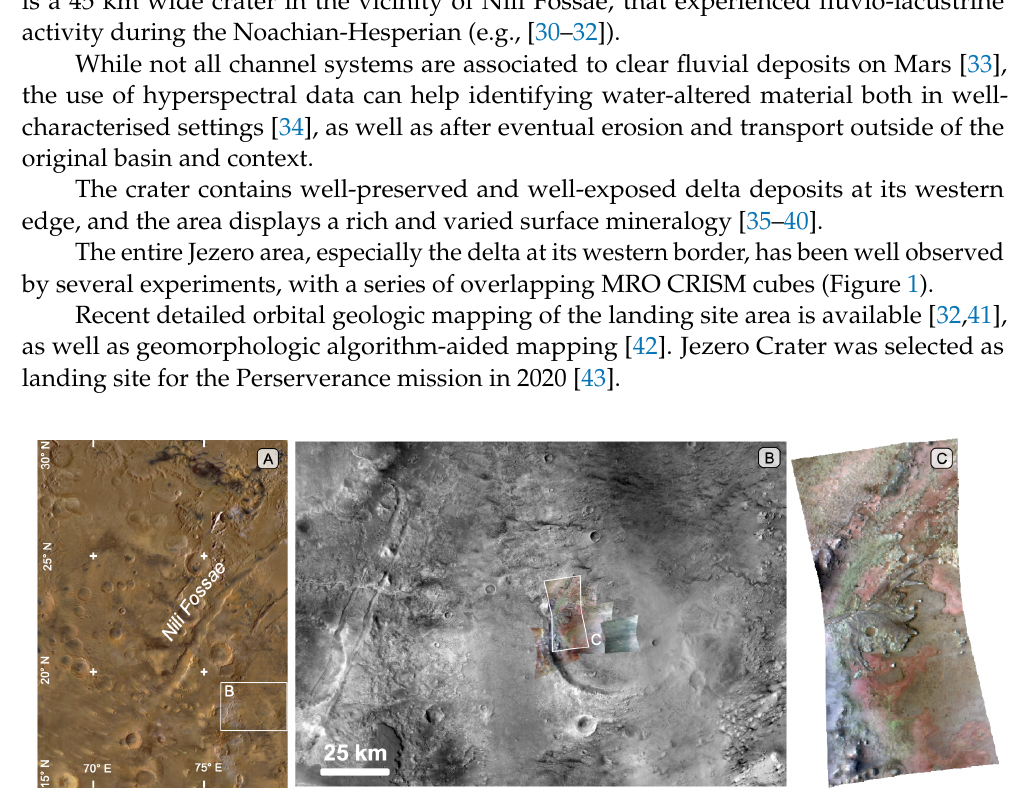
Figure 1. Location map of used cubes in the present work. ( A ) HRSC MC-13 quadrant color basemap [44]: of Nili Fossae and surrounding areas, including Jezero, in the highlighted subset. ( B ) Jezero Crater CTX mosaic [45,46] with indicated CRISM observation HRL000040FF, highlighed in white of overlapping CRISM MTRDR data covering its delta. ( C ) IR enhanced color composite (FAL) using as RGB R2529, R1506, R1080 [26] for CRISM observation